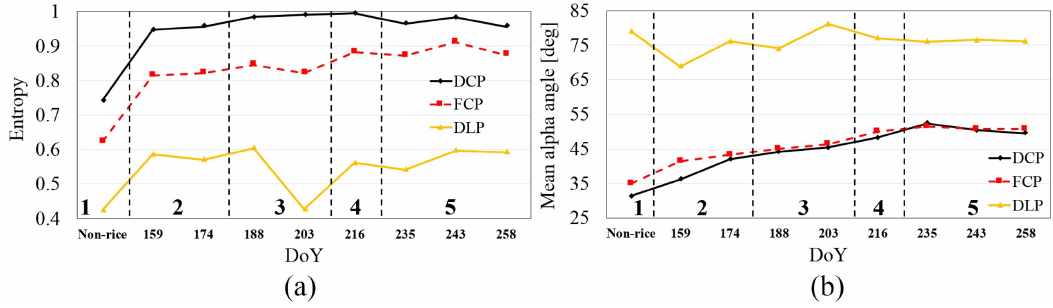
Figure 7. H /¯ α decomposition results of the FCP, DCP, and DLP modes. ( a ) Entropy; ( b ) Mean alpha.